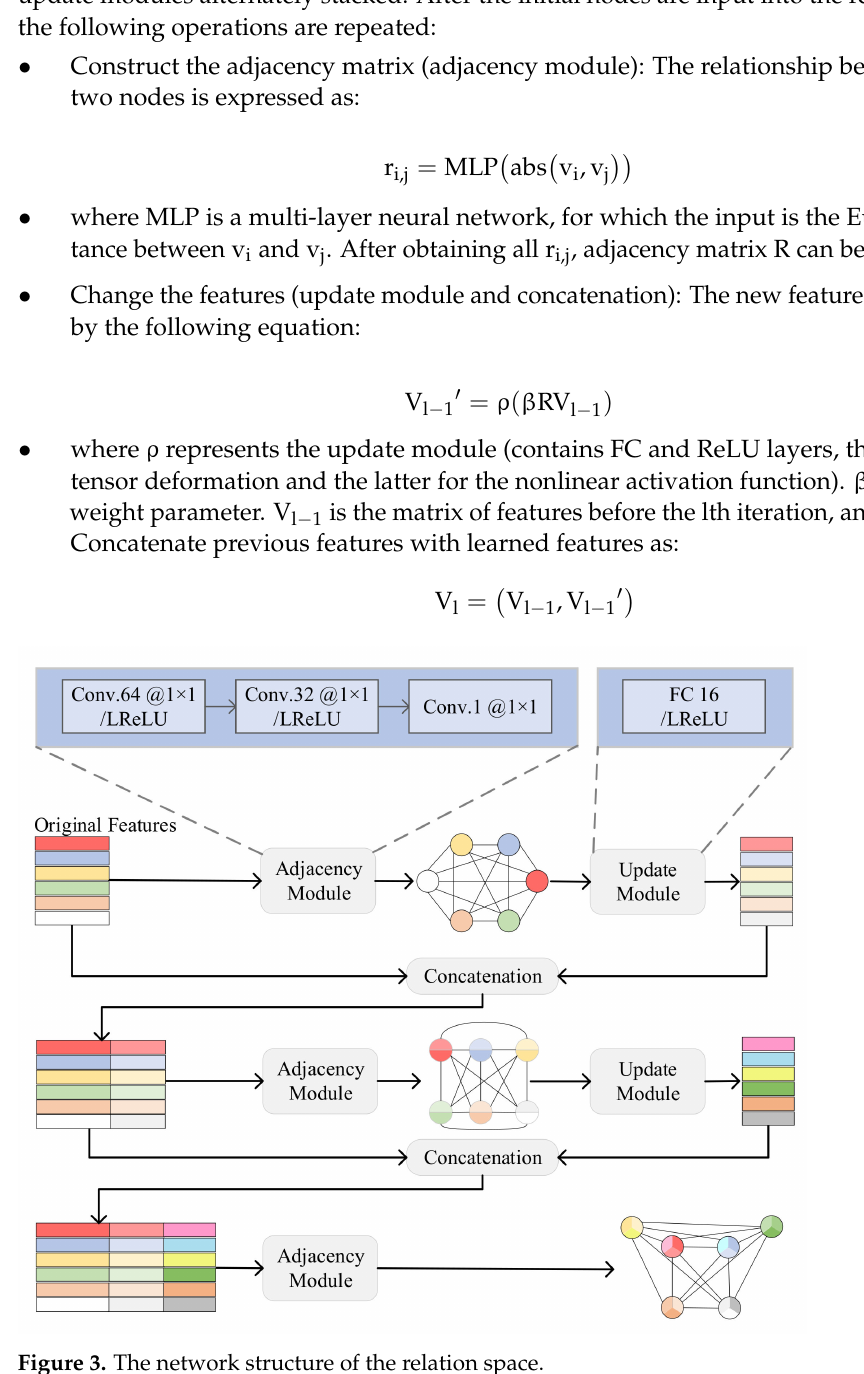
Figure 3. The network structure of the relation